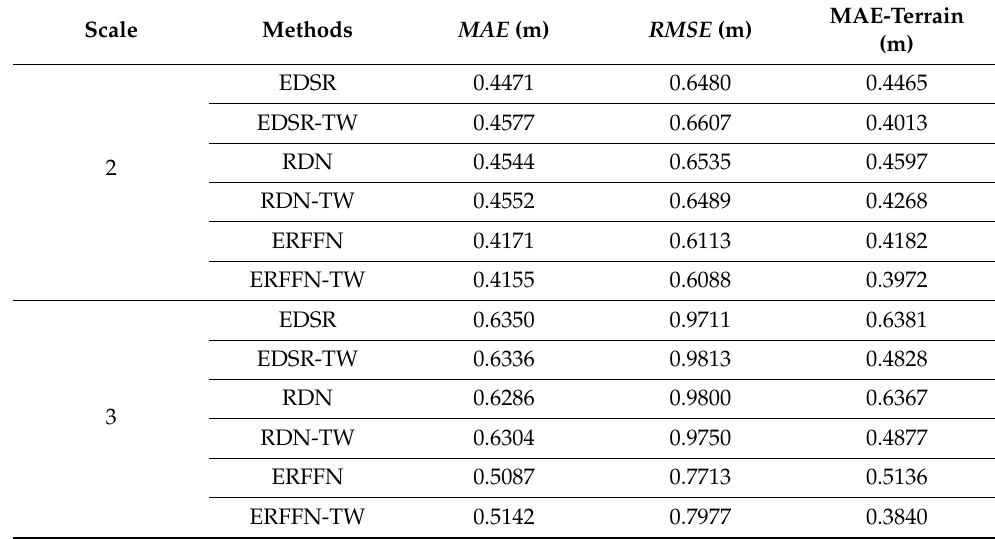
Table 6. Comparison of the performance of SR models trained using different loss modules for different reconstruction